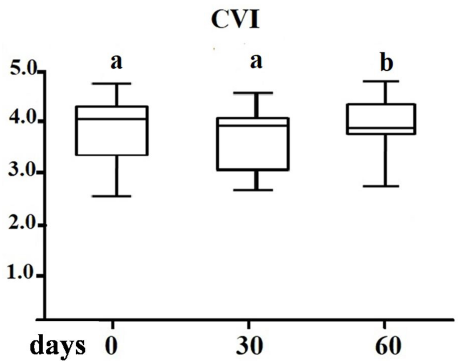
Figure 9. Comparison between the means of the indexes, as a function of days, referring to the value of Cardiovagal Index (CVI), before and after rhinoplasty surgery. Different letters (“a” and “b”) along the one of the columns indicate significant difference at 5%